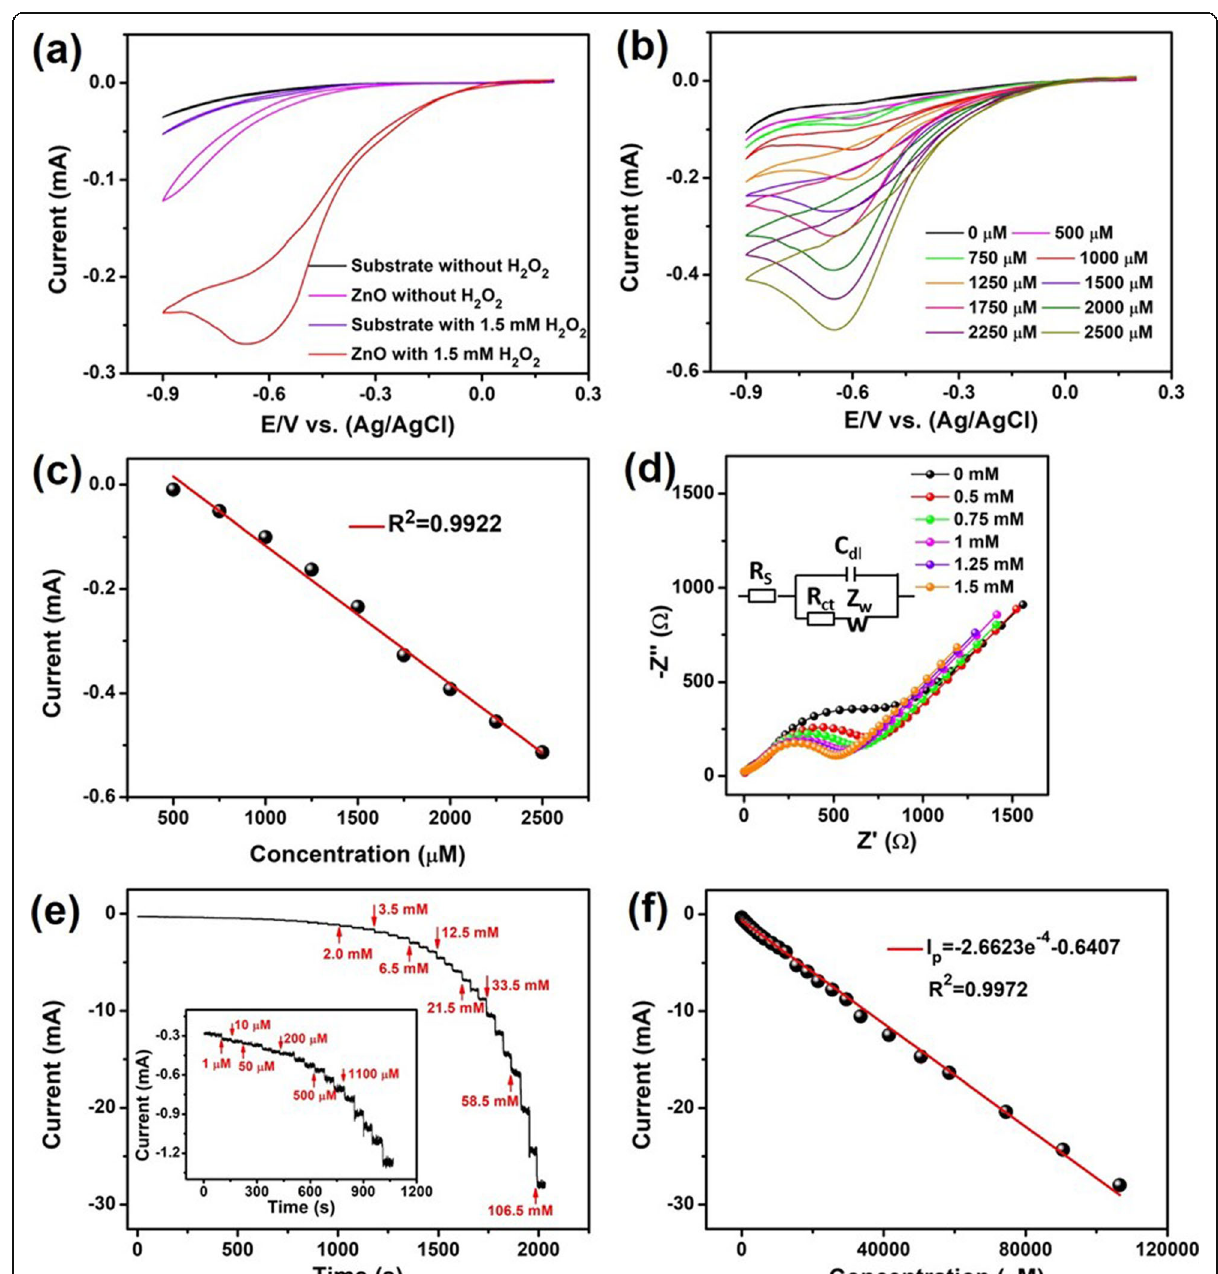
Fig. 5 a Measured CVs for the blank substrate and 1.3-nm-thick ZnO electrode at the absence and presence of 1.5 mM H 2 O 2 . b CV curves of ZnO with the different concentrations of H 2 O 2 . c Corresponding linear plot of the current peak versus H 2 O 2 concentration. d Nyquist plots of 1.3-nm- thick ZnO with various